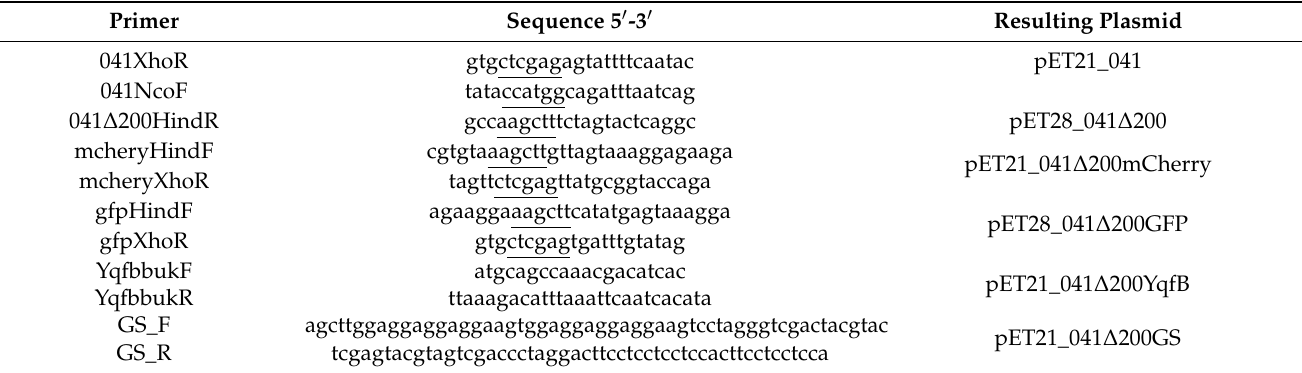
Table 1. Primers used for amplification of genes. The restriction endonuclease recognition sites are underlined. Primer Sequence 5 (cid:48) -3